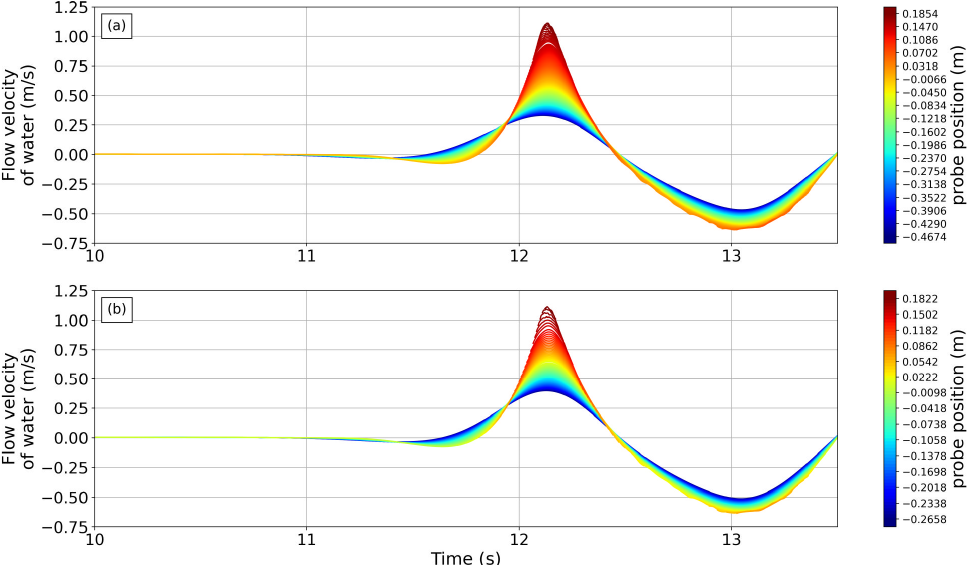
Figure 11. Time histories of pre-calculated flow velocities at probe points in the first scenario for the single cylinder immersed to a depth of z = − 0.4690 m ( a ) and to a depth of z = − 0.2690 m ( b ). The color bar indicates the vertical position of the probe points.